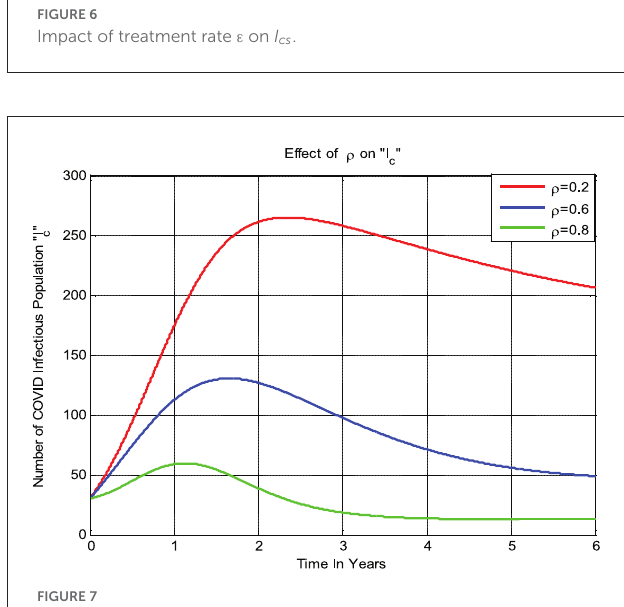
FIGURE4 Effect of COVID-19 protection rate on R c 0 .